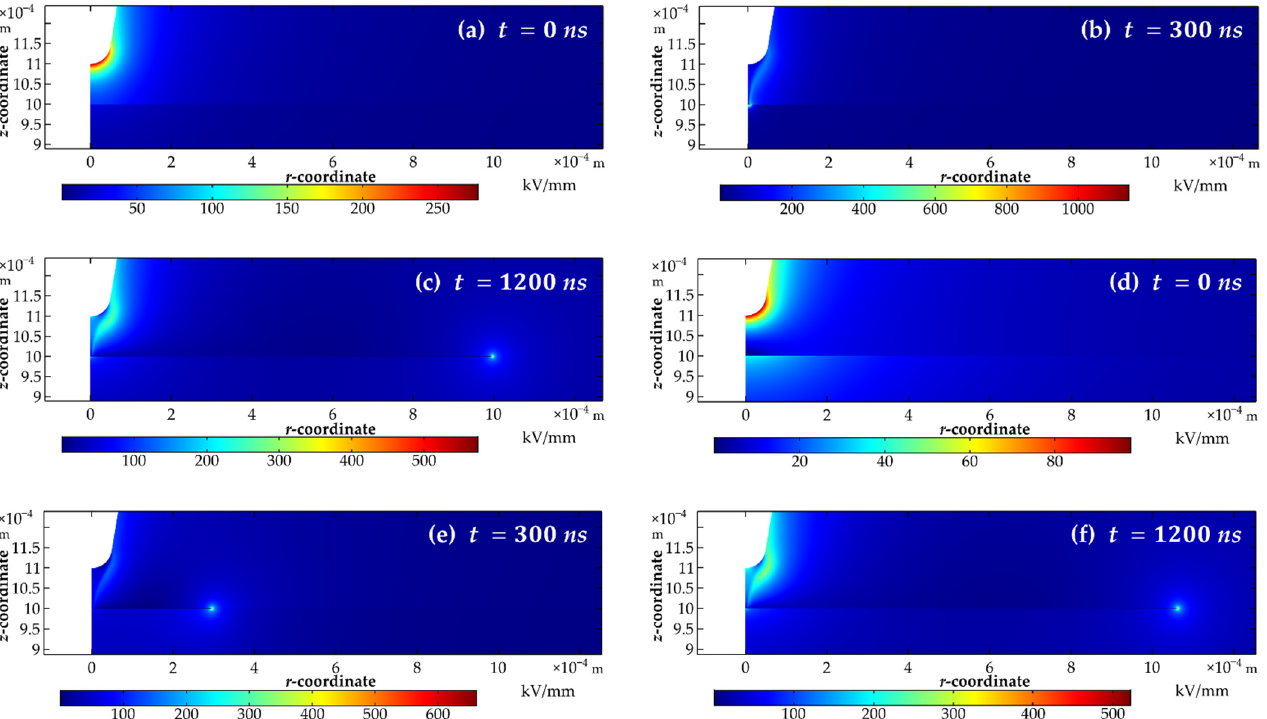
Figure 15. Two-dimensional plane distribution of the electric field magnitude (kV/mm) at different instants: ( a – c ) 3rd case; ( d – f ) 4th case case with V DC = − 20